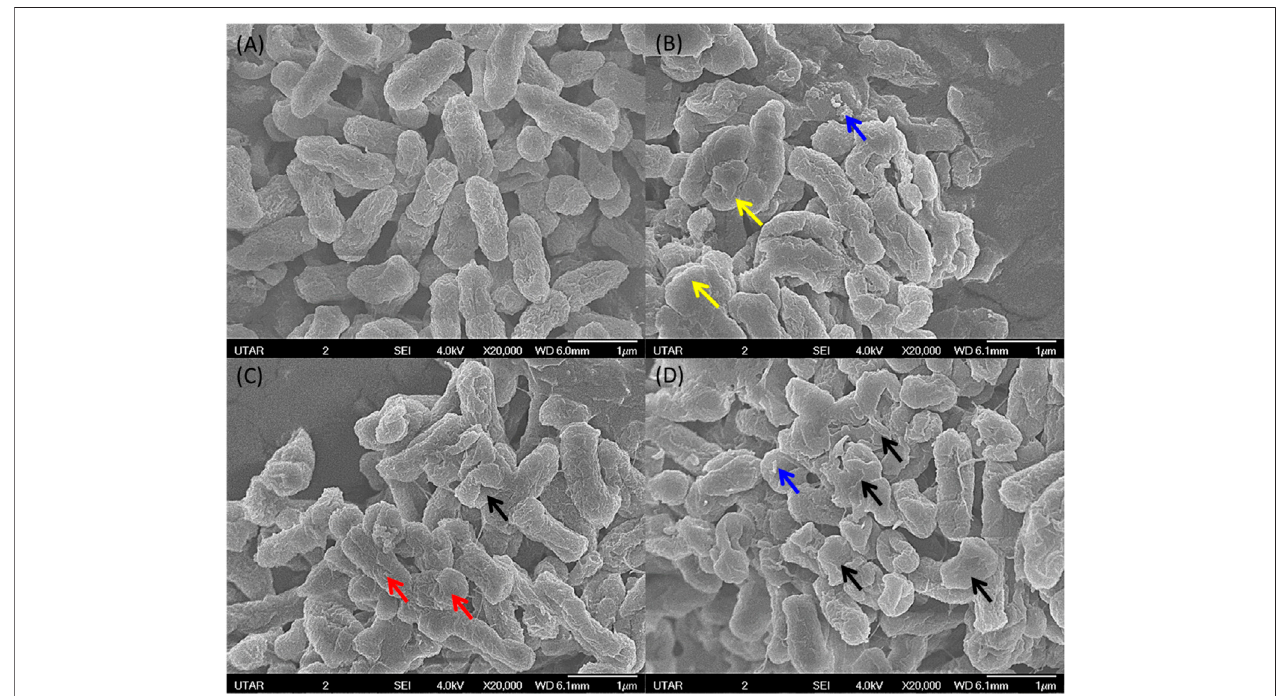
FIGURE10| SEMimagefromnegativecontrolof S.marcescens withsmoothsurfaceandintactcellwall (A) . S.marcescens upontreatmentwith160 μ g/mlofZnO NPsat24 h (B,C) and (D) showingtheattachmentofNPs(bluearrow),wrinkledcellsurface(redarrow),ruptureofcellmembrane(blackarrow),andcelldistortion(yellow